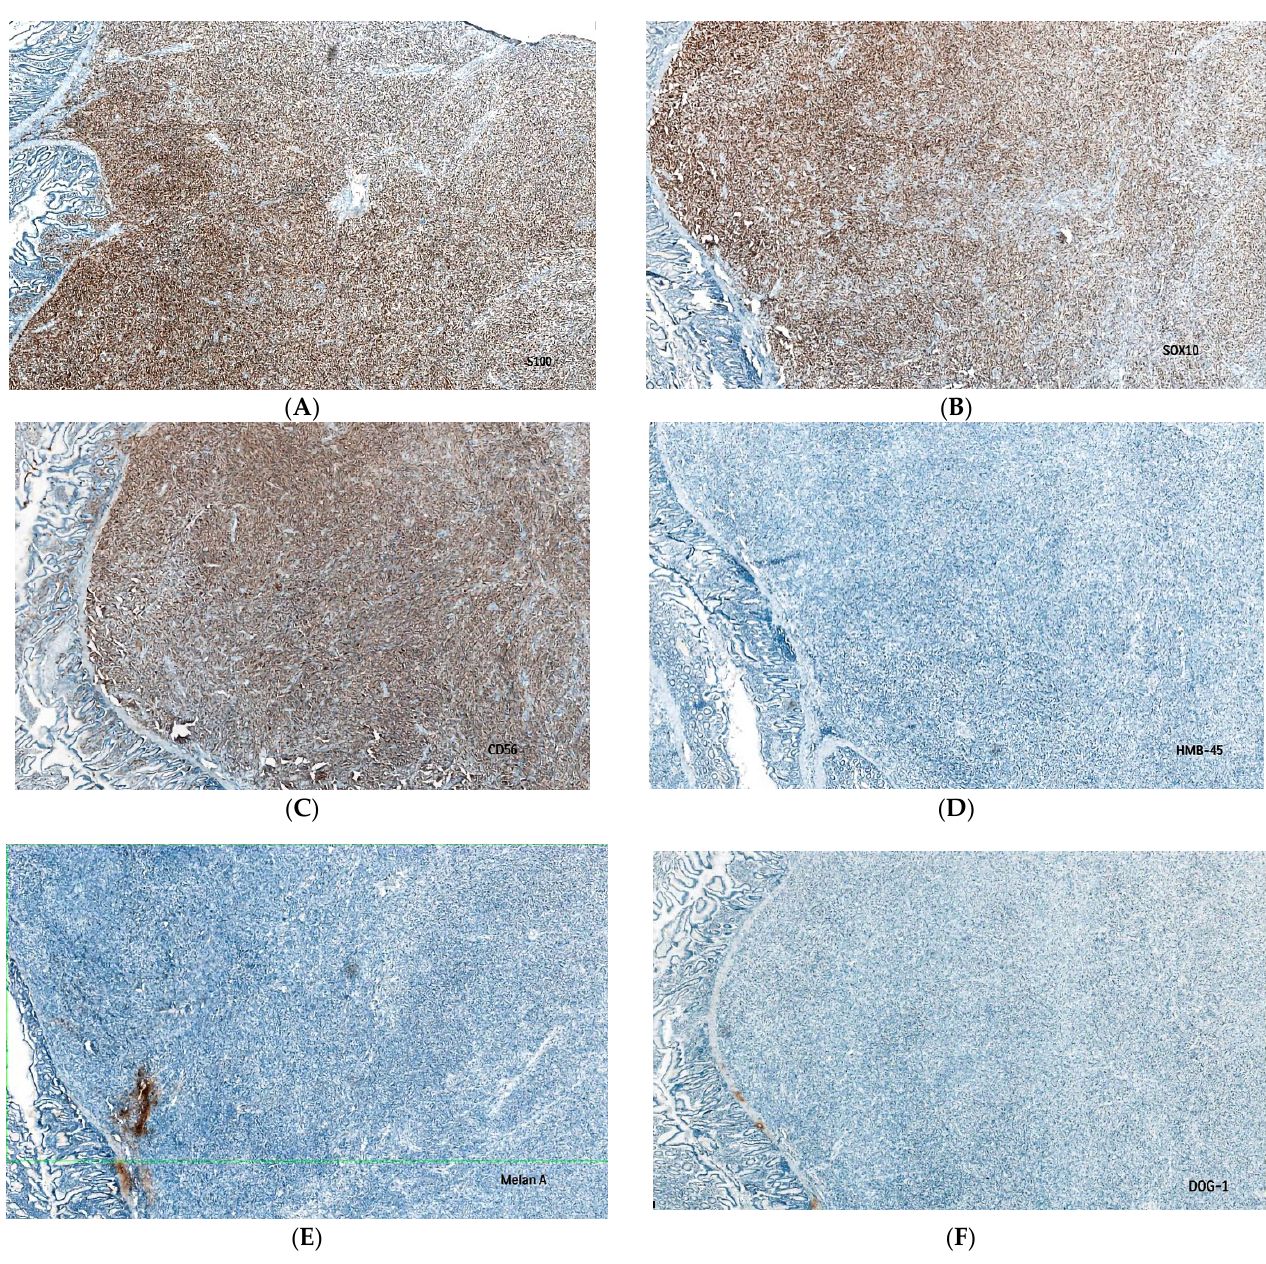
Figure 3. Immunohistochemical evaluation of the surgical specimen. ( A ) The image shows a 95% positive immunostain for the S100+ biomarker (IHC; 40 × ). ( B ) The SOX10 biomarker was positive in 90% of the cells within the tumor (IHC; 40 × ). ( C ) The image shows positive cells for the CD56 biomarker. ( D ) Negative immunostain for HMB-45 biomarker (IHC; 40 × ). ( E ) Negative immunostain for Melan-A biomarker (IHC; 40×). ( F ) The image shows tumor cells negative for the DOG-1 biomarker (IHC; 40×).